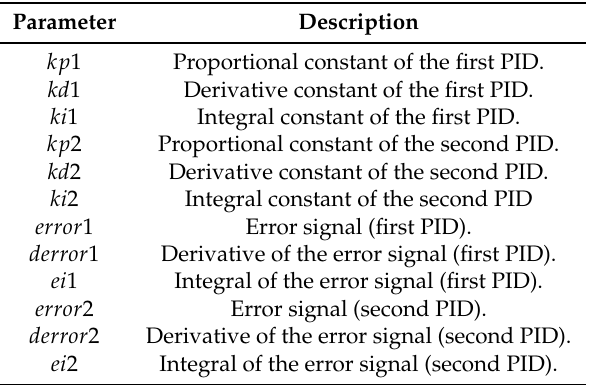
Table A11. Parameters and variables of PID controller.